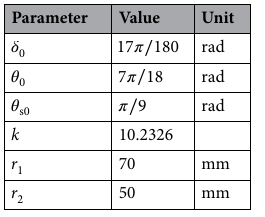
Table 1. Parameters of the cam ring slot.